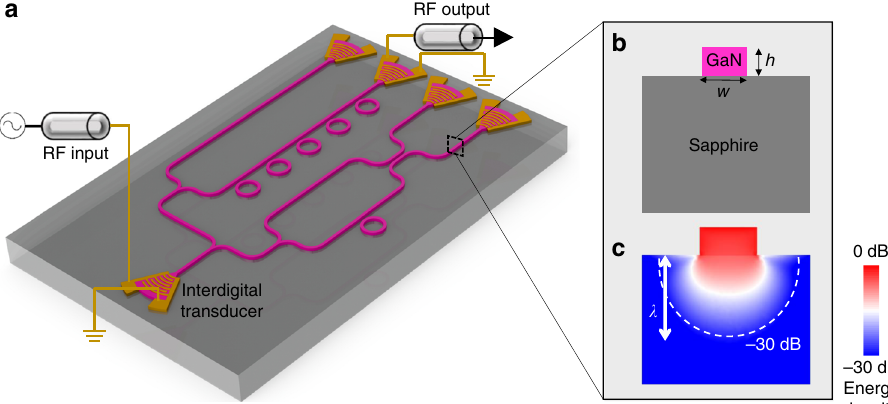
Fig. 1 Phononic integrated circuit. a A notional schematic of a phononic circuit. Input radio-frequency (RF) photons are fi rst converted into phonons by an interdigital transducer (IDT) through the piezoelectric effect of the top gallium nitride (GaN) epi-layer. The phonons are con fi ned, routed through phononic circuit and received by output IDTs. b A schematic cross-section of GaN-on-sapphire strip waveguide with thickness h and width w . c Simulated cross- sectional acoustic energy distribution of a Rayleigh-like mode shown in logarithmic scale, indicating con fi nement of acoustic wave in the waveguide. The white dashed line marks where the energy density drops to 10 − 3 , compared with the highest energy